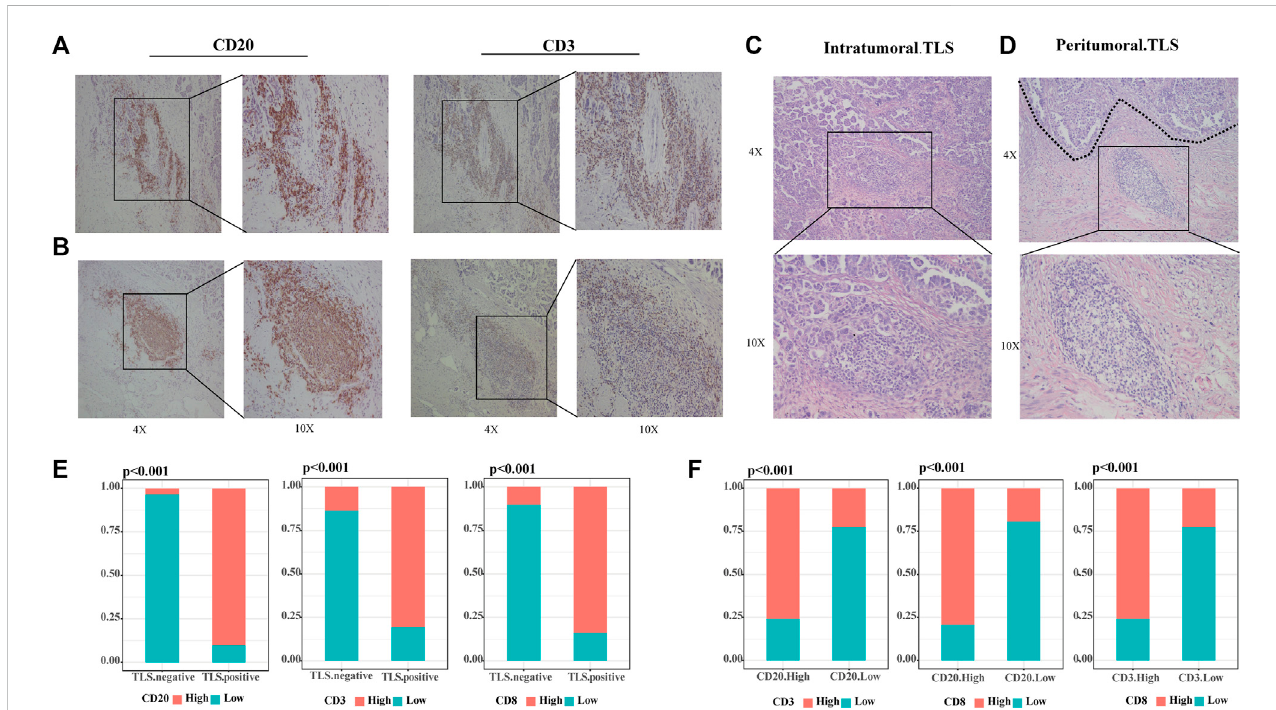
FIGURE 1 TLSs are dense clusters oflymphocytesin ovarian cancer. (A) Representative IHCimagesofimmature TLS,scatteredCD20 + Bcells without anyfollicular structure and CD3 + T cells. (B) Representative IHC images of mature TLS, CD20 + B zone form a follicular structure surrounded by the CD3 + T-cell zone. (C) Representative HE images of intratumoral TLS, immature TLS. (D) Representative HE images of peritumoral TLS, mature TLS. (E) Comparison of lymphocyte distributionbetweenTLS-positiveandnegativegroups, p -valuewasdeterminedbythechi-squaretest. (F) Correlationbetweenlymphocytedistribution, p -value was determined by the chi-square test. (Scale bar, 200 μ m in “ 4X ” pictures, 100 μ m in “ 10X ” pictures; p <